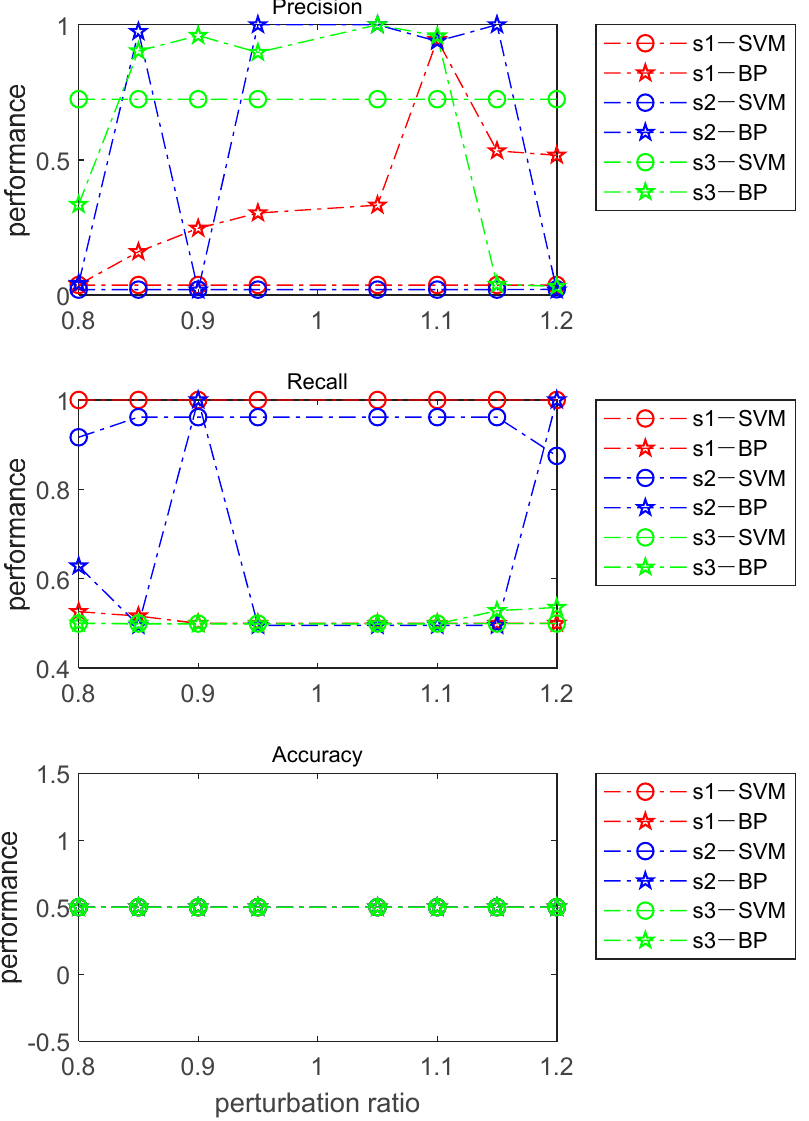
Figure 13. Fluctuation in the three index values when the disturbance ratio changes from 0.8 to 1.2.